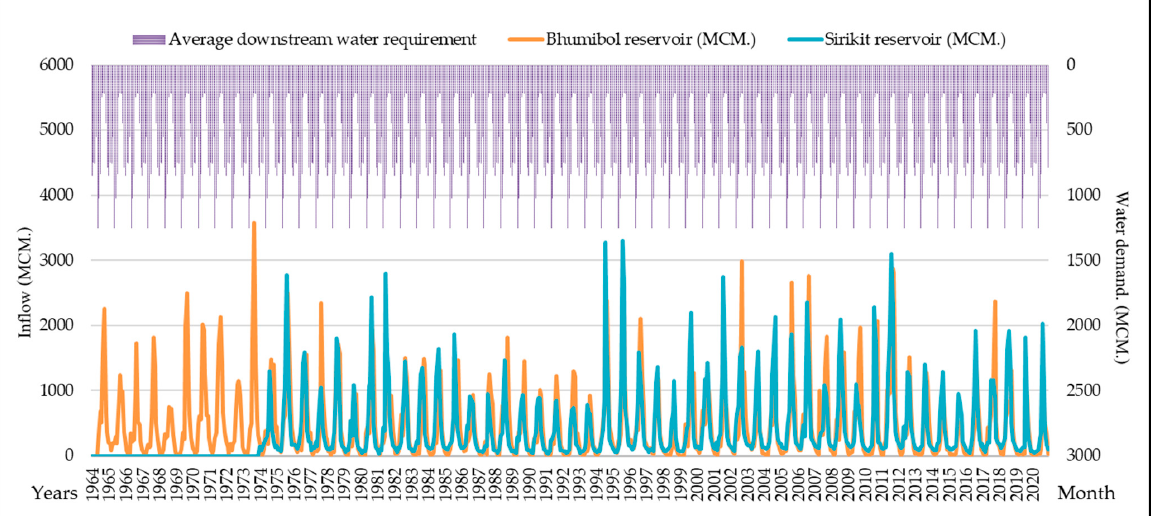
Figure 2. Locations and schematic diagram of Bhumibol and Sirikit reservoirs.